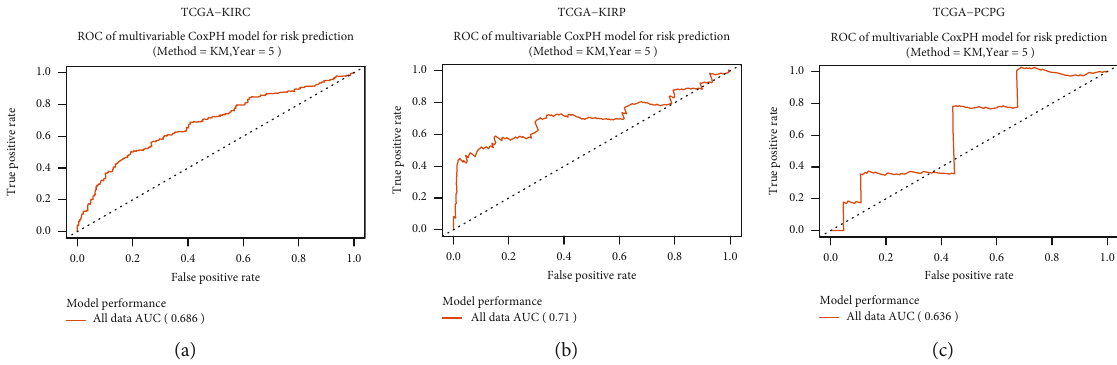
Figure 7: The clinical value of the cGAS-STING score in KIRC, KIRP, and PCPG. (a) Receiver-operating characteristic (ROC) analysis of the sensitivity and speci fi city of the risk prediction by the cGAS-STING score in KIRC. (b) ROC analysis of the sensitivity and speci fi city of the risk prediction by the cGAS-STING score in KIRP. (c) ROC analysis of the sensitivity and speci fi city of the risk prediction by the cGAS- STING score in PCPG. AUC indicates the area under the ROC